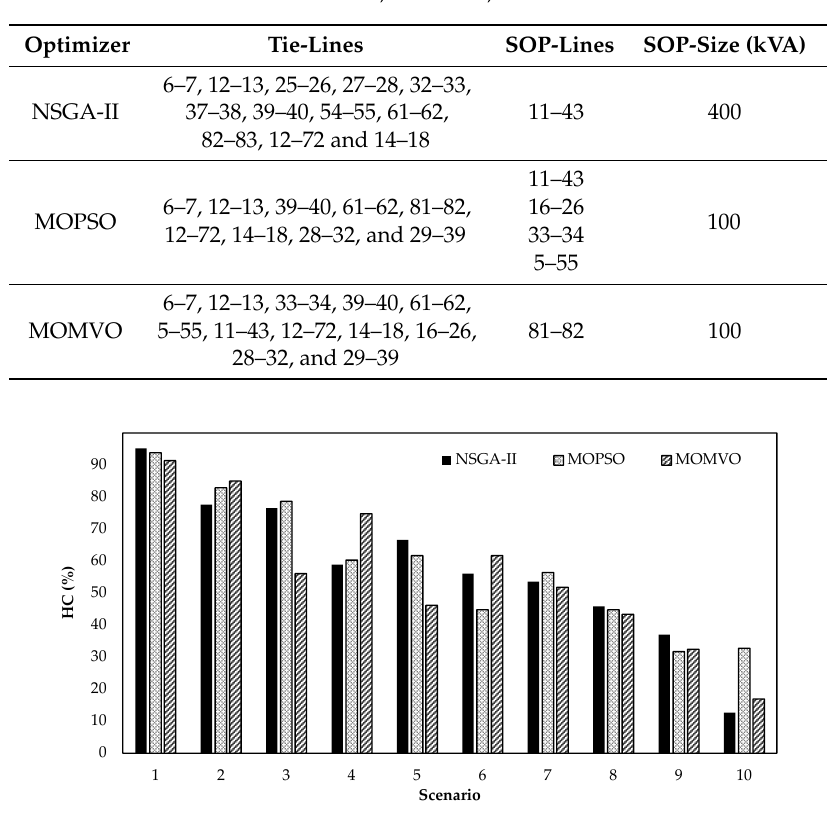
Figure 11. HC for each scenario: 83-node distribution system.